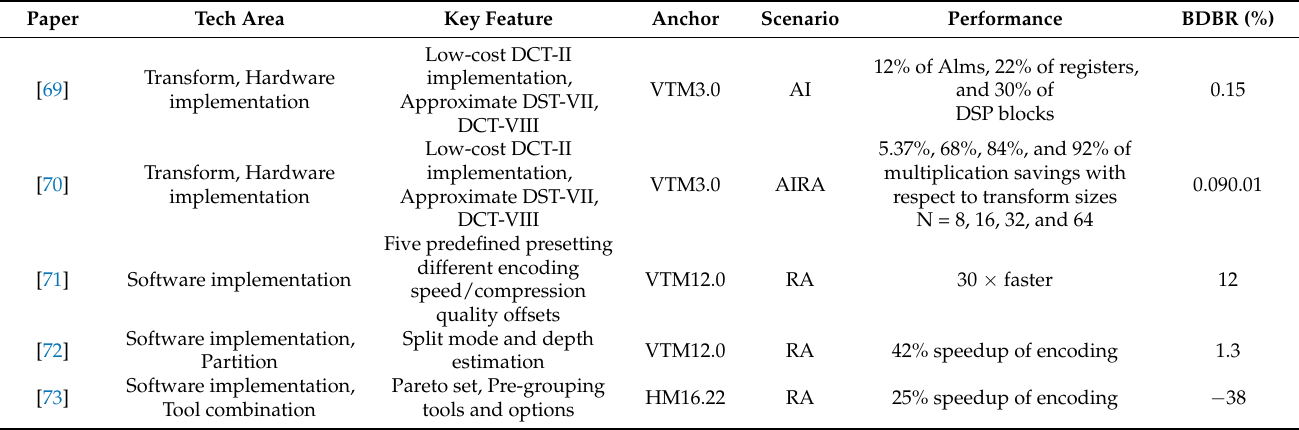
Table 4. Platform-dependent low-complexity